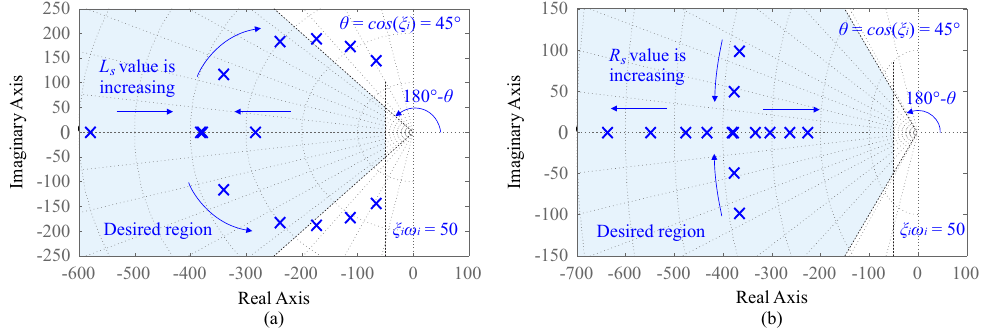
Figure 12. Closed-loop poles for current control when ( a ) L s varies and ( b ) R s